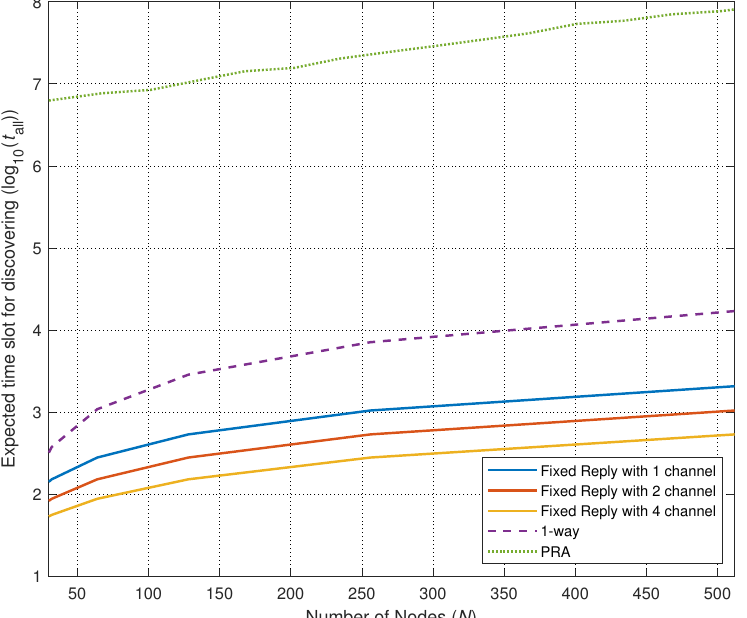
Figure 10. Comparison between neighbor discovery algorithm with fixed reply ( K =